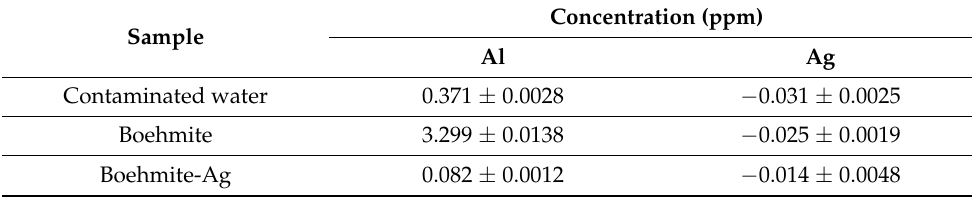
Table 5. Aluminum and silver concentration (ppm) in water after